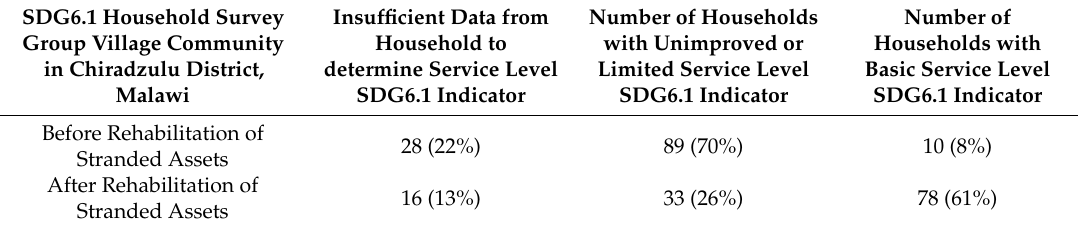
Table 2. SDG6.1 Household Survey before and after intervention to rehabilitate Stranded Assets identified in Chiradzulu District Malawi. Indicators were explicitly based on the Joint Monitoring Programme (JMP) definitions as described in Figure